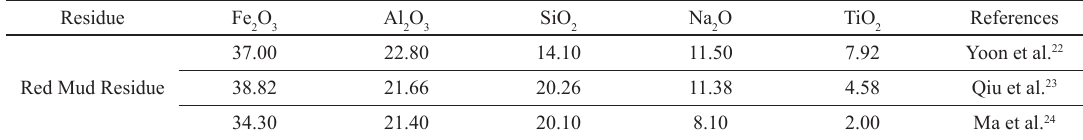
Red Mud Residue